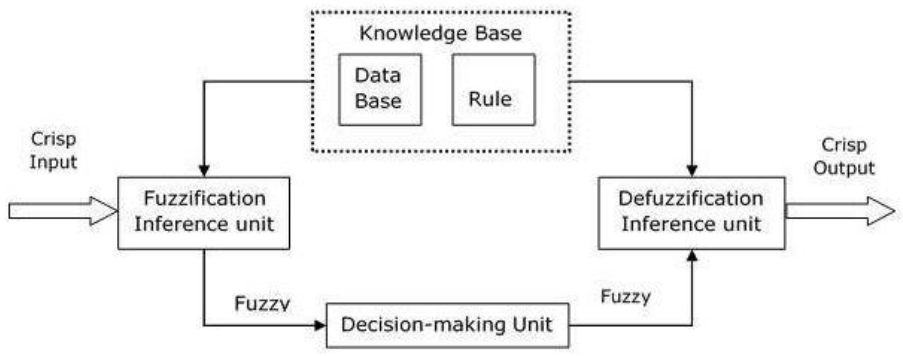
Figure 4. A basic FIS (fuzzy inference system) process.